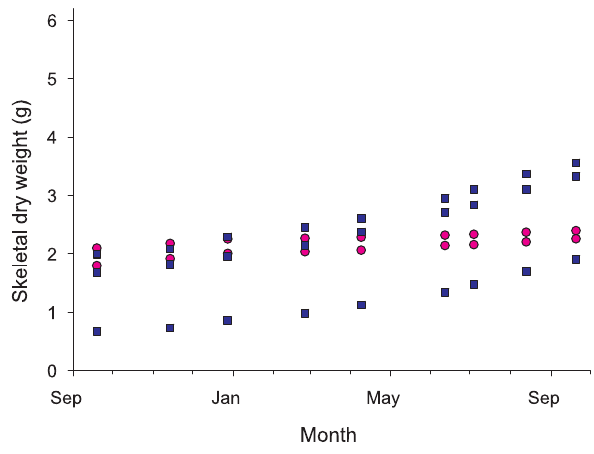
Fig. 2. Example plot of coral skeletal dry weights (calculated from buoyant weights) versus time. Data come from 24 ◦ C azooxanthel- late corals under ambient conditions. Values for females are indi- cated by pink circles, males by blue